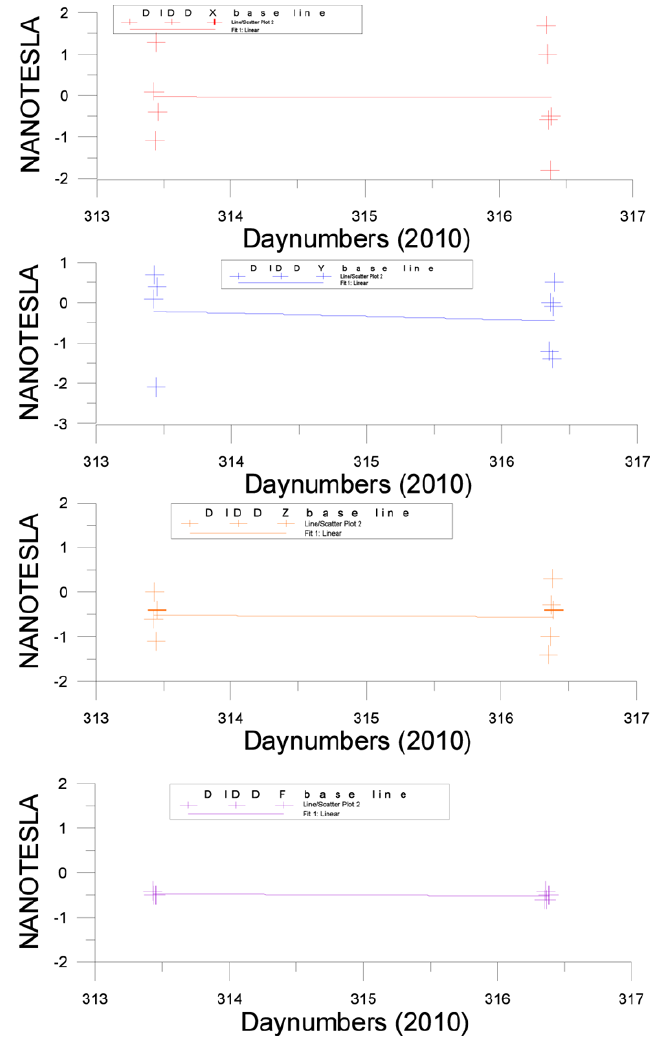
Figure 13. The adopted baseline of DIDD in the Aggtelek station. The crosses mean the bases belonging to the individual absolute measurements.